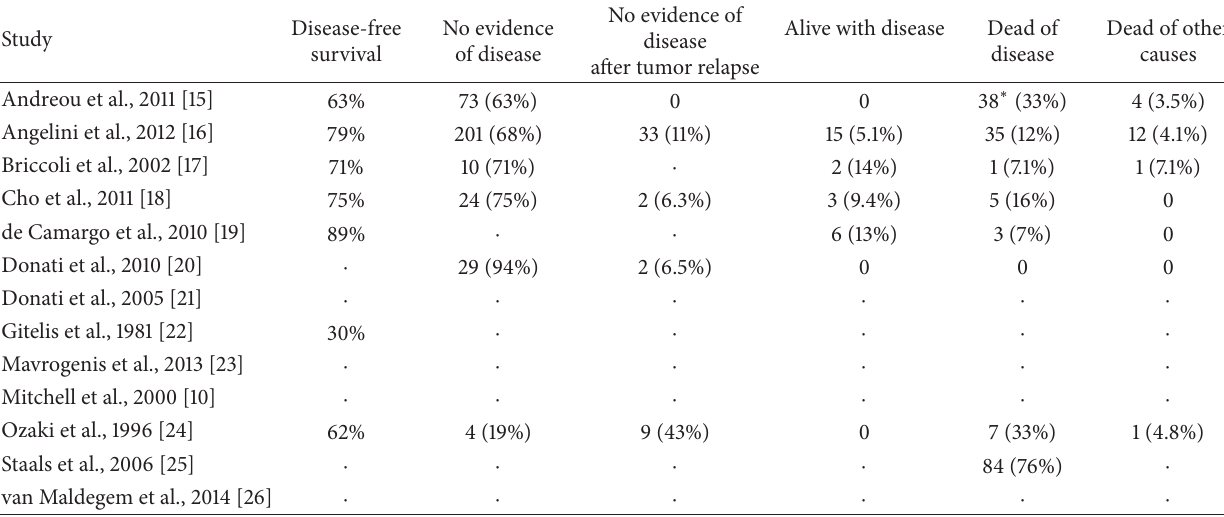
Table 4: Oncologic outcome,